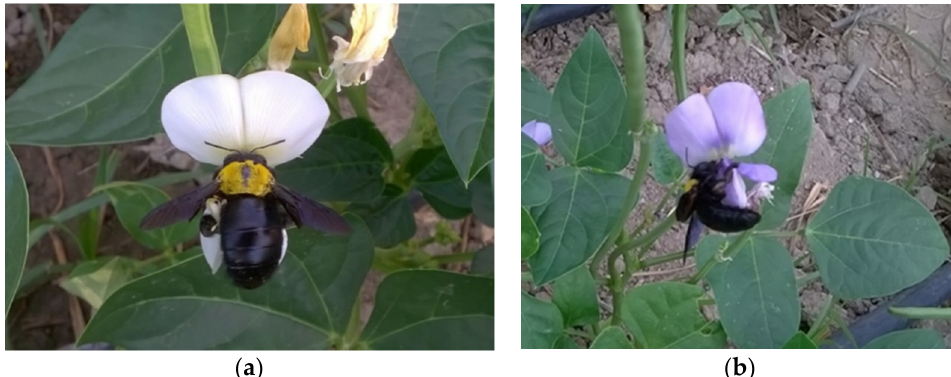
Figure 2. ( a ) Positive visit of a pollinator on cowpea flower; ( b ) Non-positive visit of a pollinator on cowpea flower.